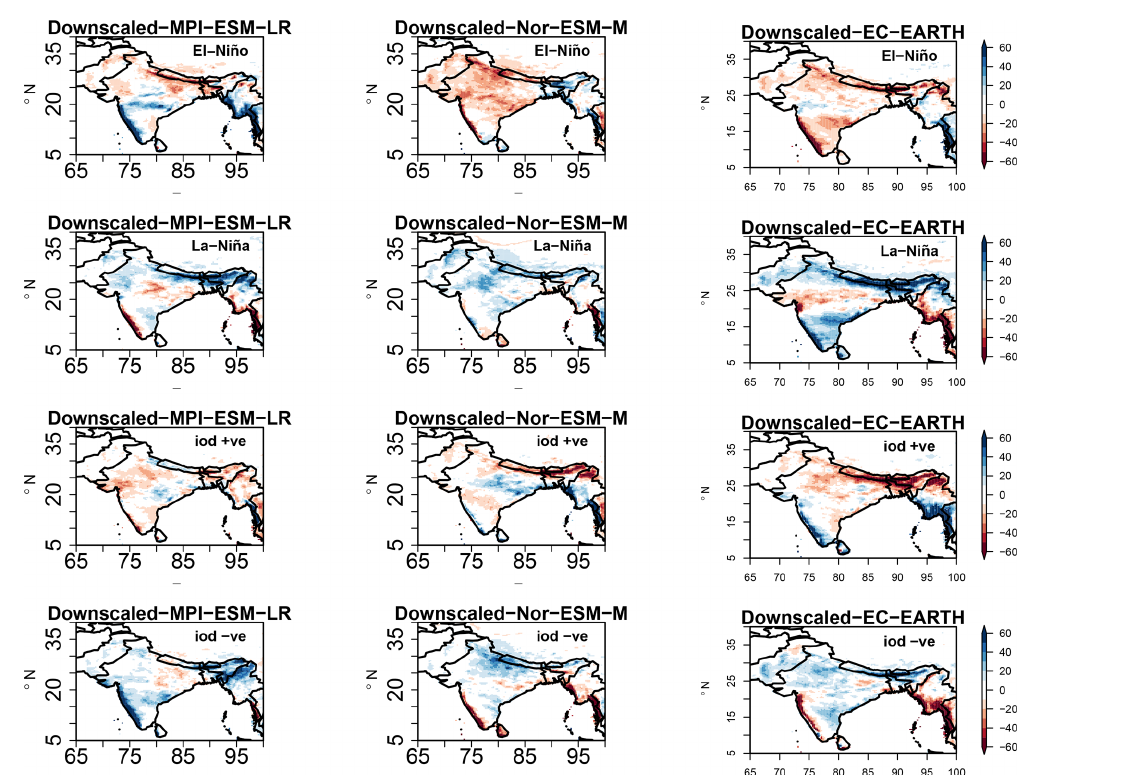
Figure 10. Total precipitation anomaly composites over the Indian subcontinent for El Niño, La Niña, and positive IOD and negative IOD events for the downscaled COSMO-crCLM simulations driven by MPI-ESM-LR, Nor-ESM-M, and EC-EARTH GCM simulations for JJAS